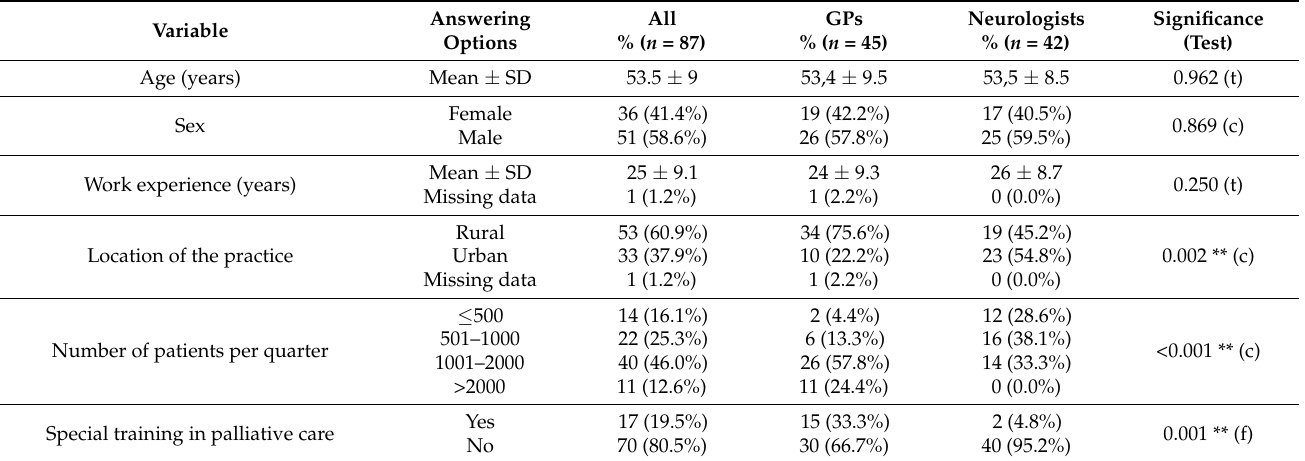
Table 1. Demographic data of the survey